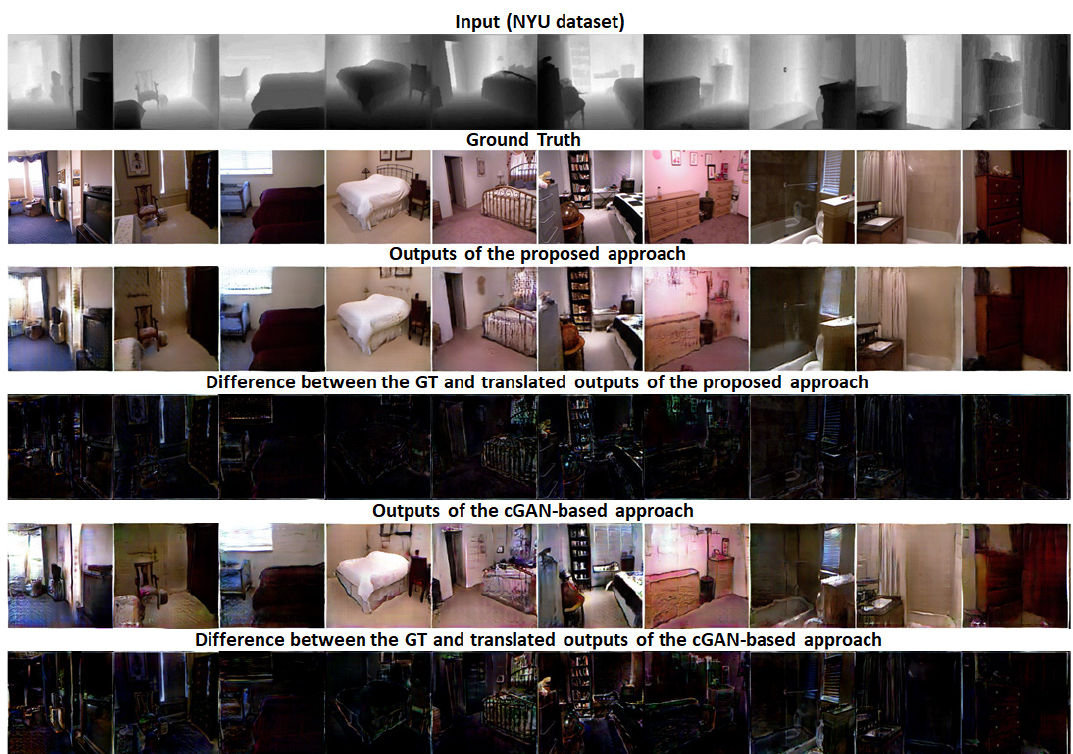
Figure 4. Input test samples in domain y are translated to domain x samples by the proposed